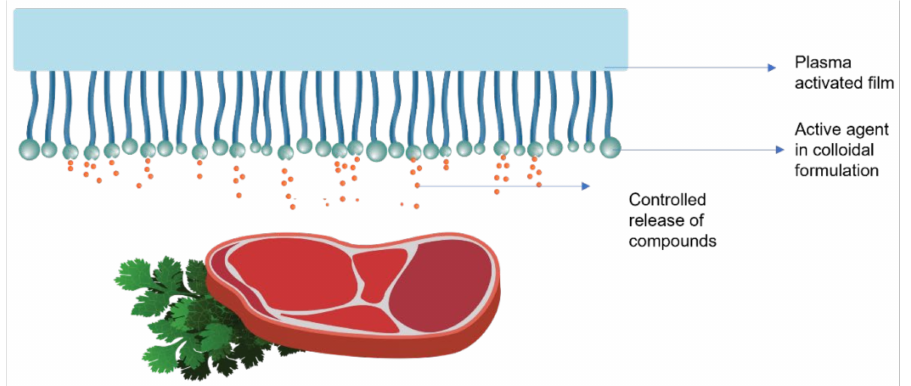
Figure 12. Schematic representation action of coatings as a colloidal formulation in active food